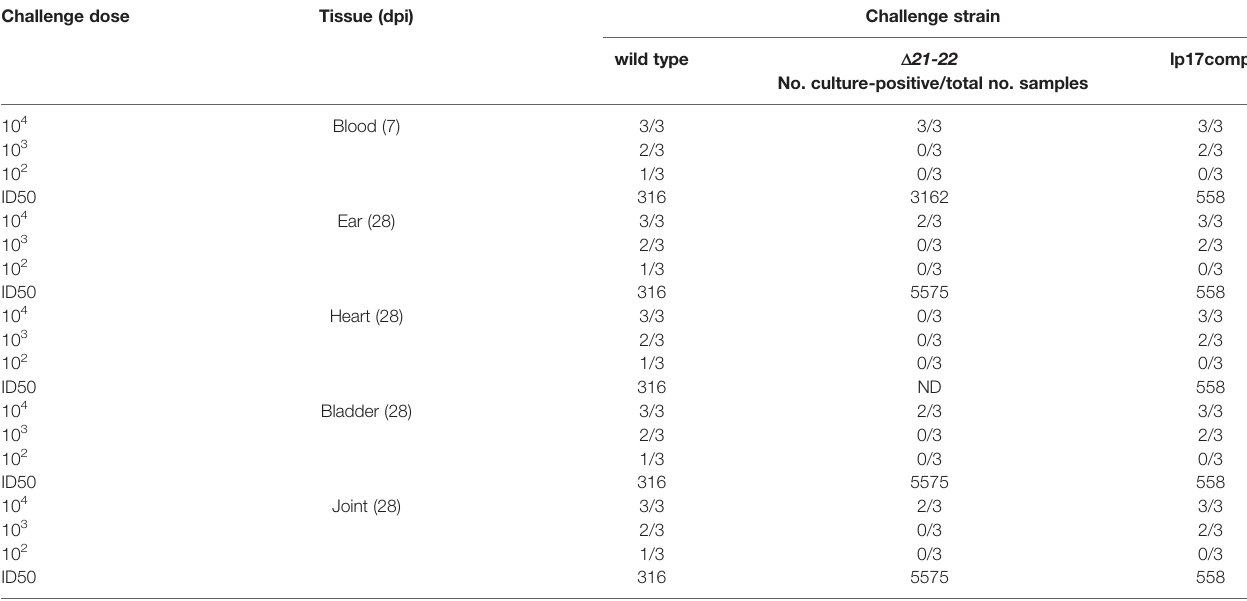
TABLE 1 | Minimum infectious dose and tissue colonization of wild-type, D 21-22 , and lp17comp B. burgdorferi strains in immunocompetent C3H mice. Challenge dose Tissue (dpi) Challenge